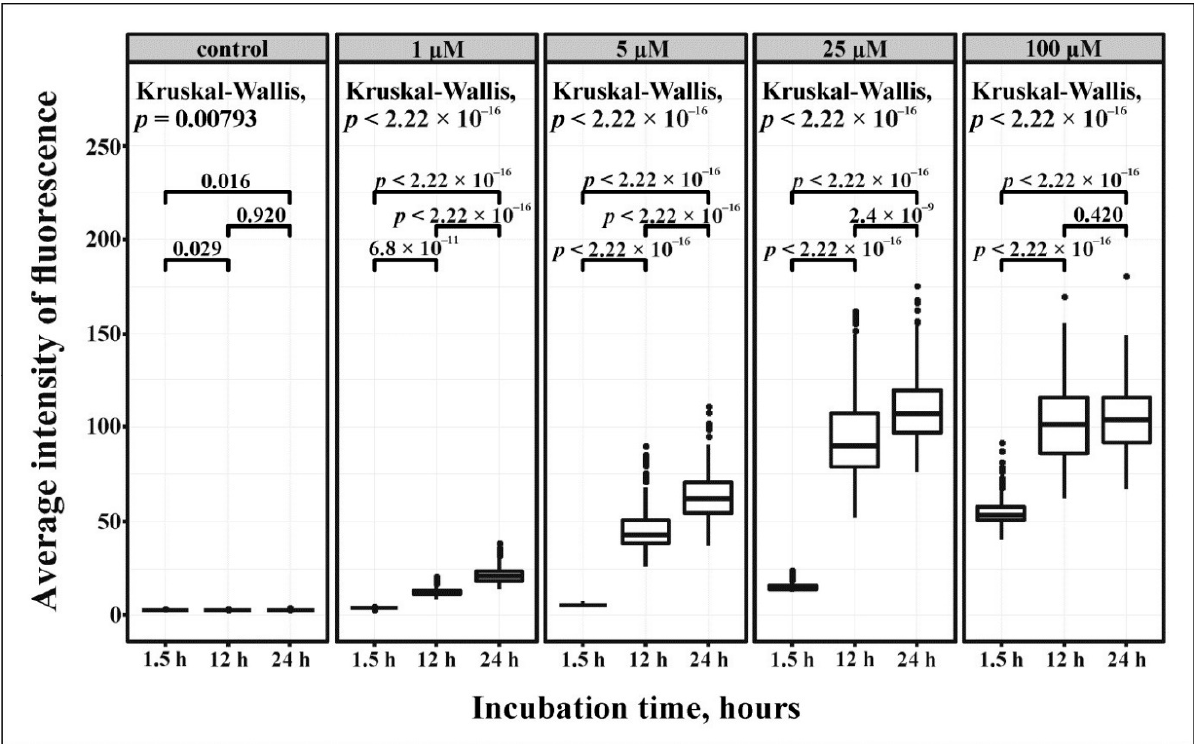
Figure 11. Comparison of the average fluorescence intensities observed in Ehrlich ascites carcinoma cells after 1.5, 12, and 24 h of incubation with BODIPY 1 at concentrations of 1, 5, 25, and 100 μ M. Medians, first, and third quartiles are presented; significant differences are considered when p -value < 0.05. A posteriori comparison was performed with incubation time.